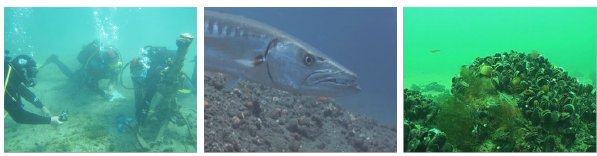
Figure 1. Examples of underwater